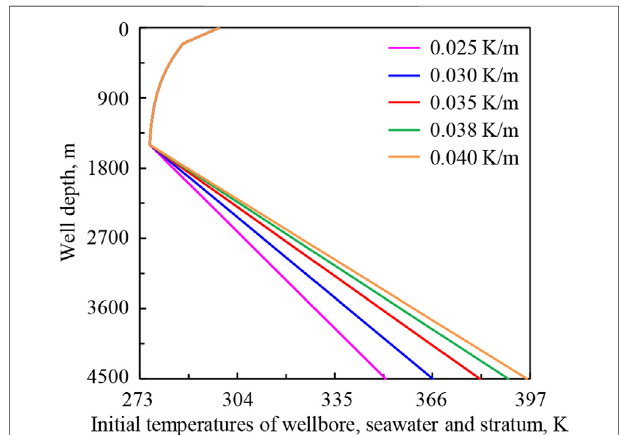
FIGURE 11 | The initial temperature distributions of wellbore, seawater, and stratum under geothermal gradients.